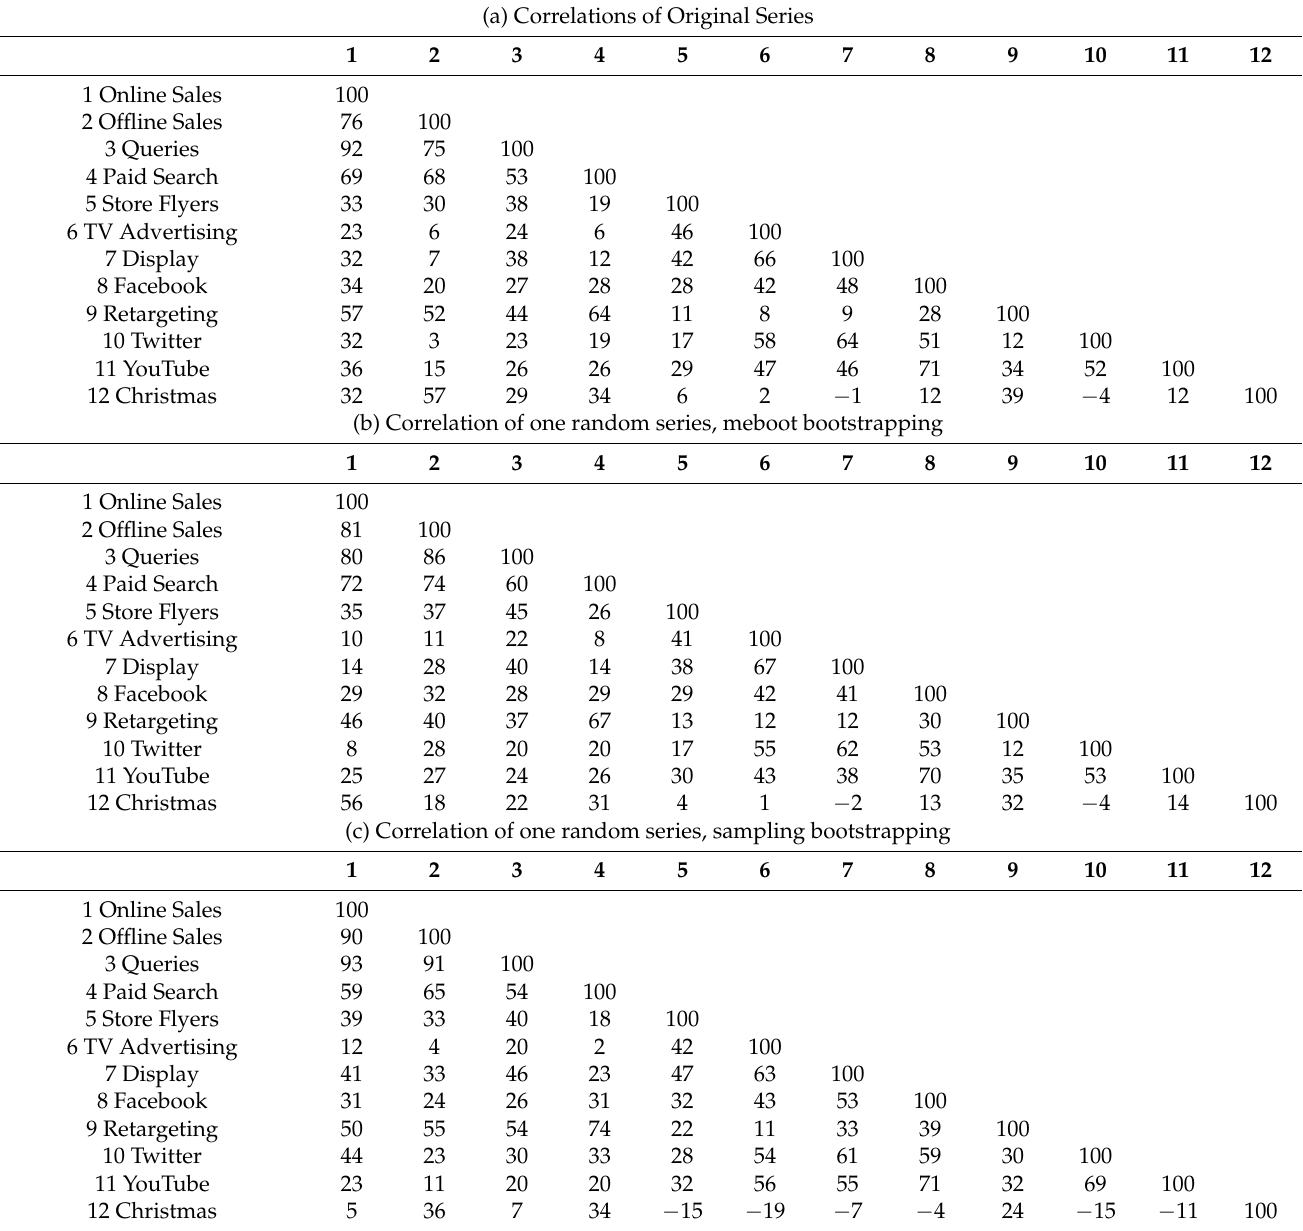
Table 2. ( a ) Correlation coefficients of the time series, ( b ) correlation coefficients of one randomly selected series from meboot, and ( c ) correlation coefficients of one randomly selected series from sampling